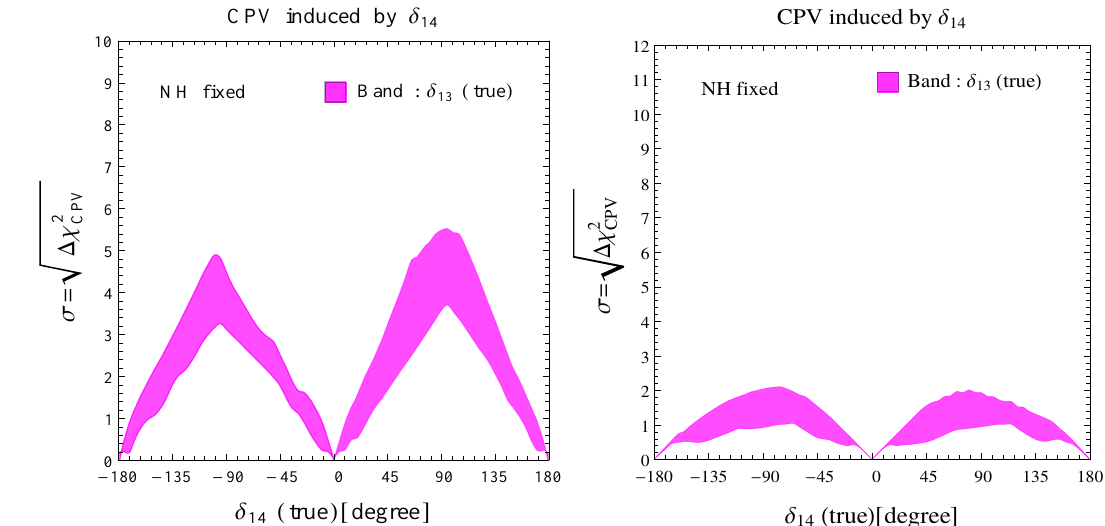
Figure 4. Discovery potential of the CPV induced by δ 14 for T2HK (left) and ESS ν SB (right), assuming the NMH is known to be the NH. We fix the true and test values of θ 14 = θ 24 = 9 ◦ , and we take the true and test θ 34 to be 0 ◦ . In both panels, the colored bands are obtained in the 3 + 1 scheme by varying the unknown true δ 14 in its entire range of [ − π , π ] in the data while marginalizing over test δ 14 in the same range. Figures taken from [50] ( left ) and [89] ( right